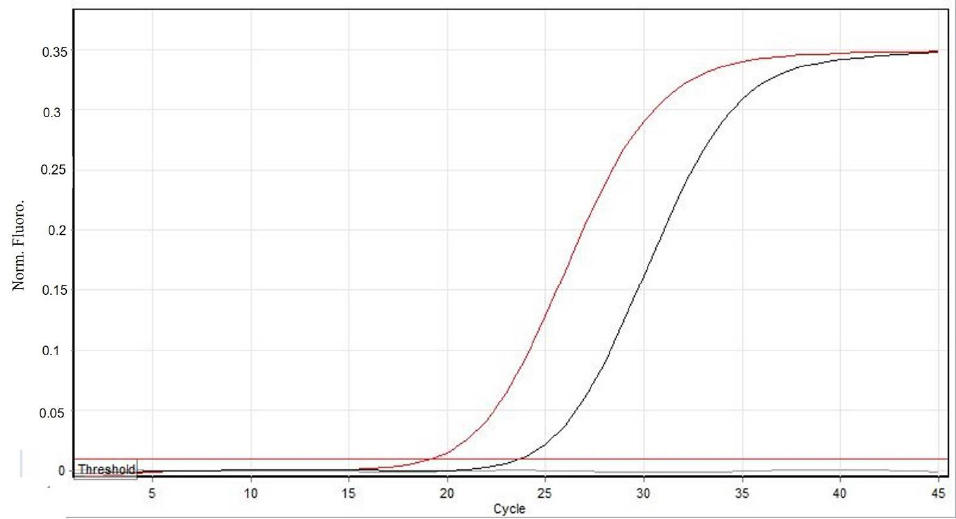
Figure 2. Result of the Taqman real-time PCR for Sarcoptes scabei var. canis ; black = positive control, grey = negative control, red = skin sample from the European wildcat.